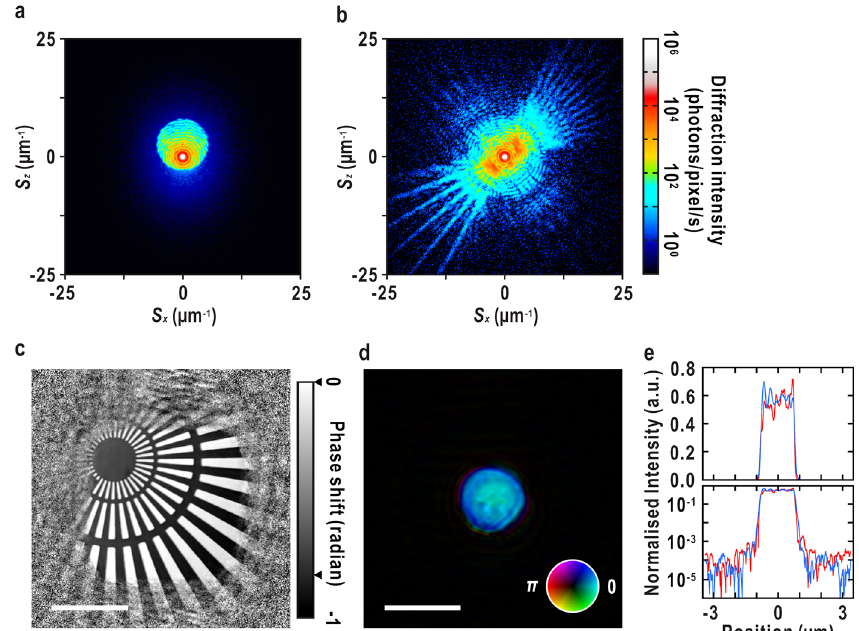
Fig. 9 Experimental demonstration of ptychography with projection illumination optics. Typical diffraction patterns without ( a ) and with ( b ) the sample, acquired at exposure times of 100 and 1 s, respectively. The colour scale is shown to the right of ( b ). c Reconstructed phase image of the sample. Theoretical phase shifts on the tantalum and fabricated regions are indicated with arrowheads in grayscale shown on the right. d Reconstructed probe wave fi eld, as in Fig. 2c. Scale bars in c , d indicate 2 μ m. e Horizontal (blue) and vertical (red) intensity pro fi les of the reconstructed probe, as in Fig.